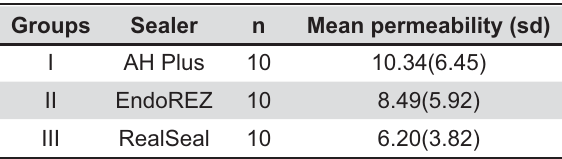
Table 1- Mean values and standard deviation of (cid:2)(cid:3)(cid:4)(cid:5)(cid:3)(cid:6)(cid:7)(cid:8)(cid:9)(cid:8)(cid:10)(cid:11)(cid:12)(cid:13)(cid:14)(cid:15)(cid:16)(cid:17)(cid:18)(cid:12)(cid:19)(cid:20)